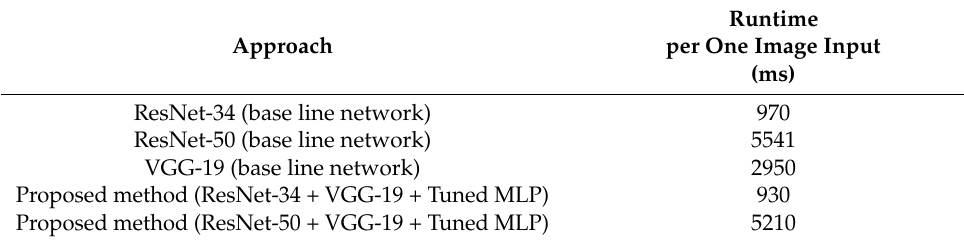
Table 8. Runtime evaluation of the proposed approach and baseline networks for 10 random selected image